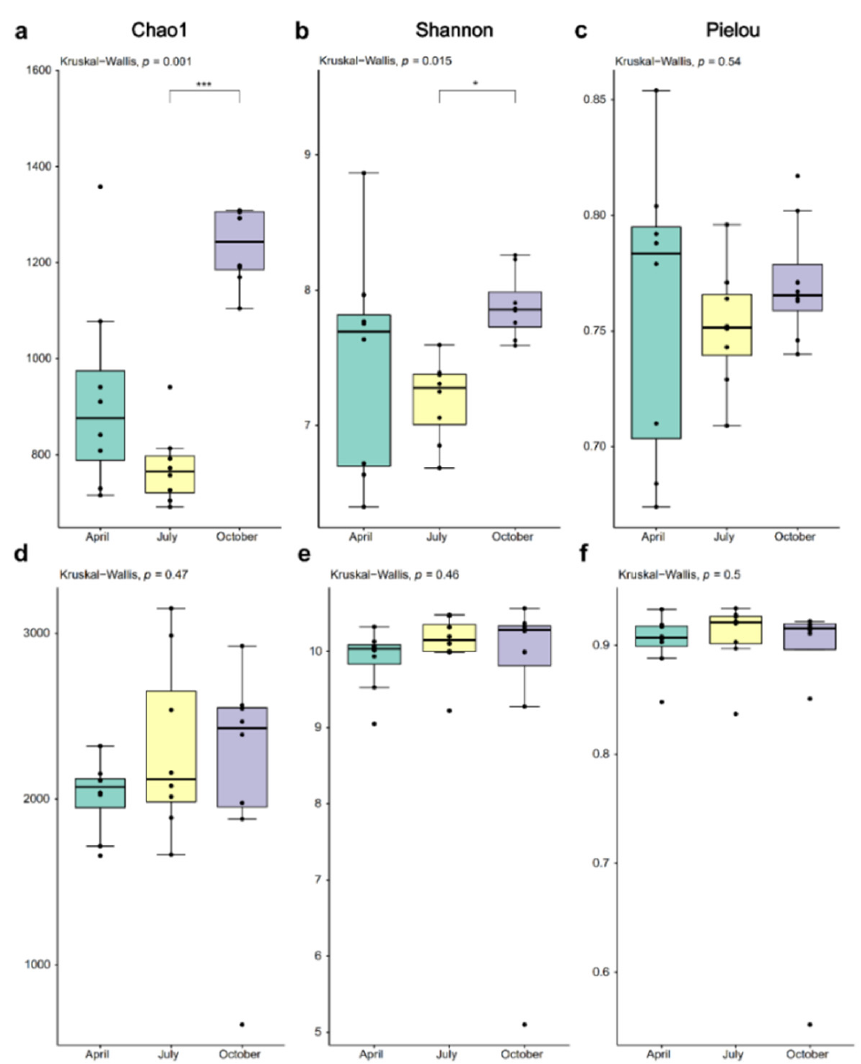
Figure 2. Comparison of alpha diversity indexes between sampling periods in two habitats with the Kruskal-Wallis test and the Dunn test (( a – c ), water; ( d – f ), sediment). *, p < 0.05, *** p < 0.001. 3.2. Community Composition and Dynamics of Bacteria in the Two Habitats Proteobacteria (44.66%, average relative abundance), Actinobacteriota (22.16%), Bac- teroidota (15.35%), Cyanobacteria (7.60%), Firmicutes (5.57%), Verrucomicrobiota (1.36%), Campi- lobacterota (0.59%), Acidobacteriota (0.37%), Bdellovibrionota (0.31%), and Chloroflexi (0.28%) were the major phyla of the whole bacterioplankton community (57 phyla) in the Ningxia section of the Yellow River (Figure 3a). Different from bacterioplankton, the bacterial com- munity in the sediment samples included 77 phyla. The primary phyla were Proteobacteria (42.20%), Bacteroidota (11.98%), Desulfobacterota (7.07%), Acidobacteriota (4.88%), Actinobacte- riota (4.18%), Firmicutes (4.06%), Chloroflexi (3.78%), Cyanobacteria (3.39%), Verrucomicrobiota (3.28%), and Nitrospirota (2.71%) (Figure 3b). A total of 37 differential phyla were screened by Welch’s t -test in both habitats. Figure 3c demonstrated that, with the exception of Actinobacteriota and Bacteroidota , the abundance of each differential phylum was higher in sediment than in